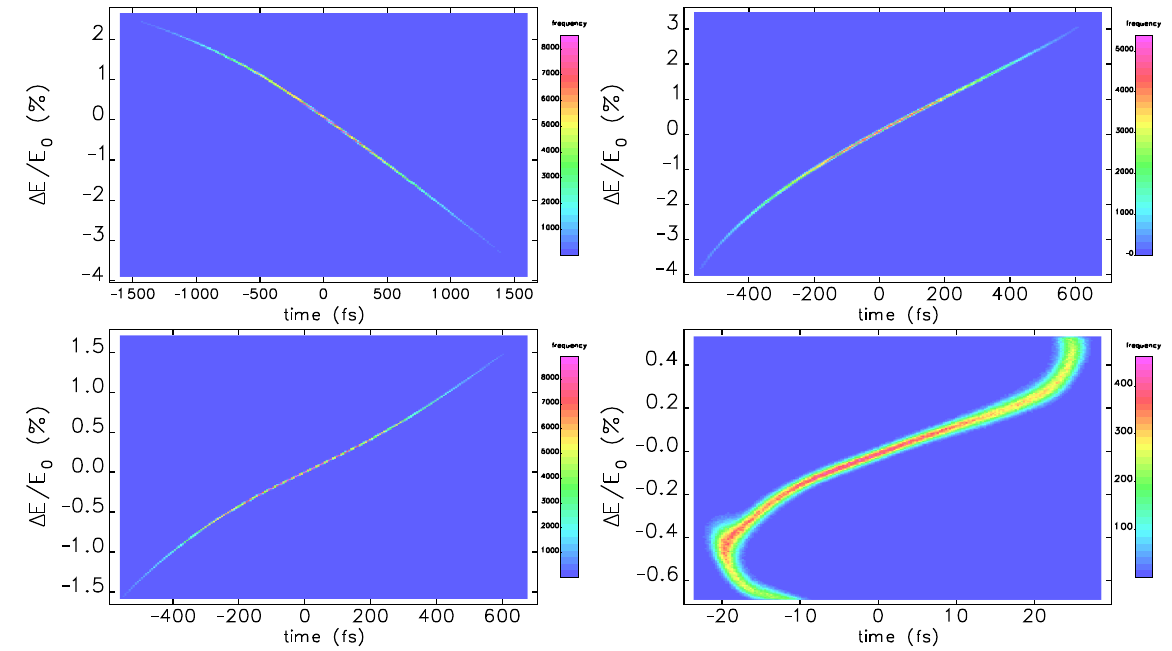
entrance.FIG. 5. Longitudinal phase space evolution. Left top: Linac1 end and BC1 entrance; right top: BC1 end; left bottom: Linac2 end and BC2 entrance; left bottom: BC2